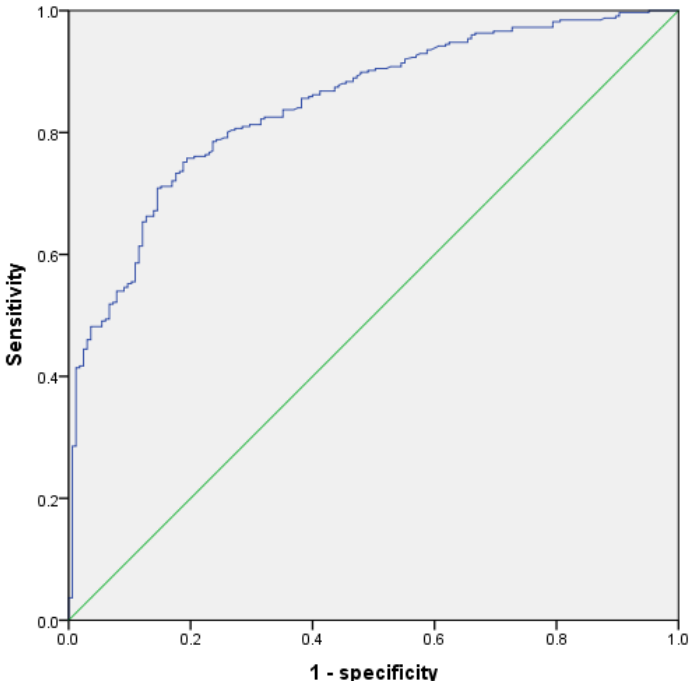
Figure 2. ROC of logistic regression model for predicting severe endometriosis with preoperative parameters.